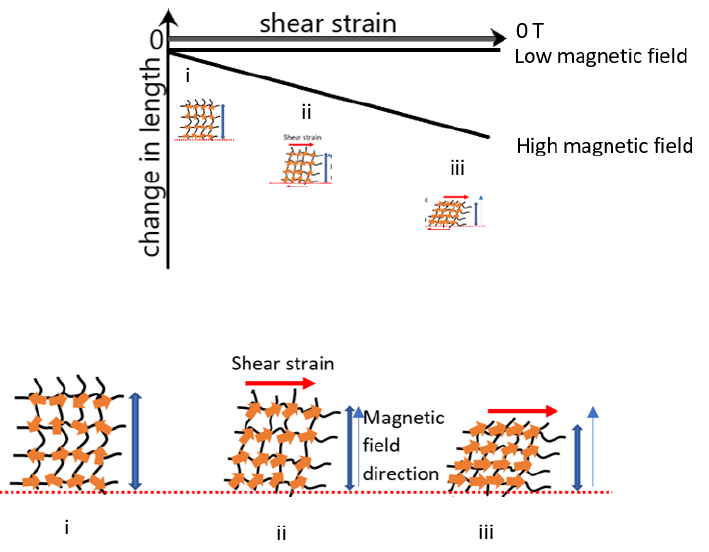
Figure 12. Change in length of MA foam under various shear strains at different magnetic field condition of zero, low and high magnetic fields.